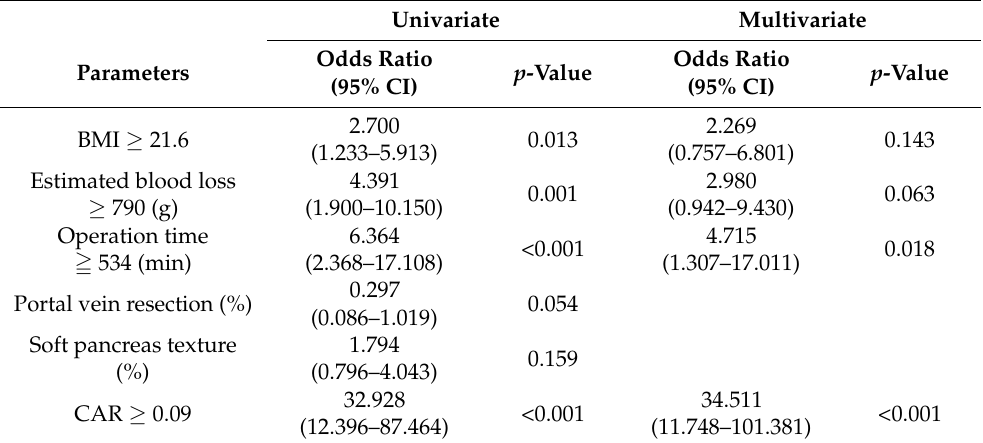
Table 3. Univariate and multivariate logistic regression analyses of predictors of postoperative pancreatic fistula. Univariate and multivariate analysis by logistical